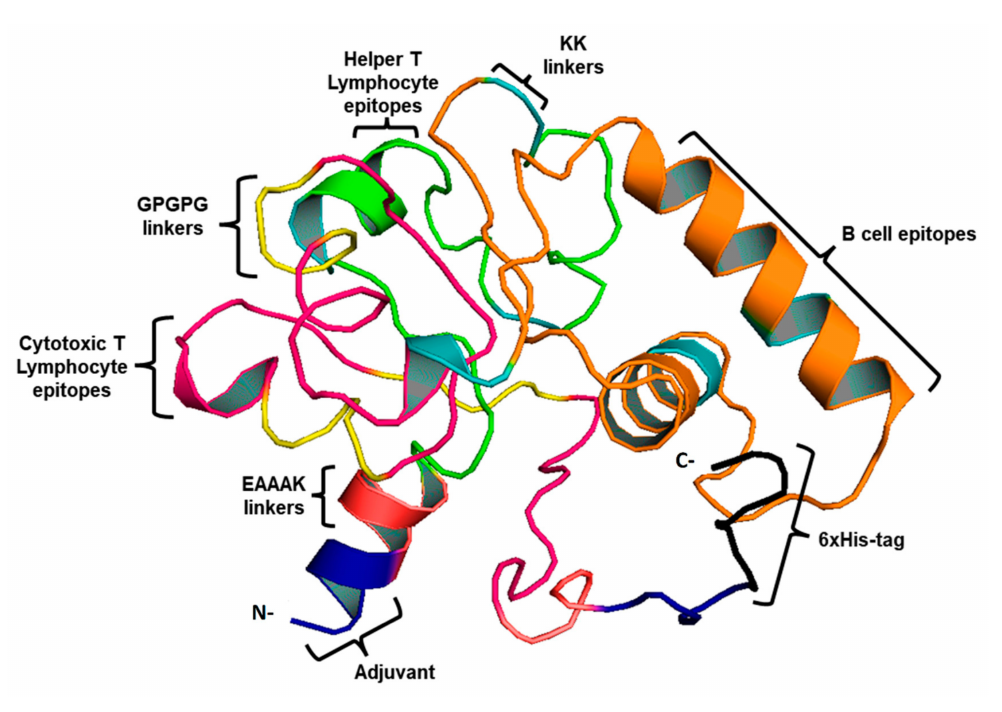
Figure 2. 3D vaccine chimera. The vaccine adjuvant is represented by the blue part, the EAAAK linker by red, CTL epitopes by pink, and AAY and GPGPG linkers are indicated by yellow. Whereas, HTL epitopes are indicated by the green color and LBL by the orange. Black represents the 6-His